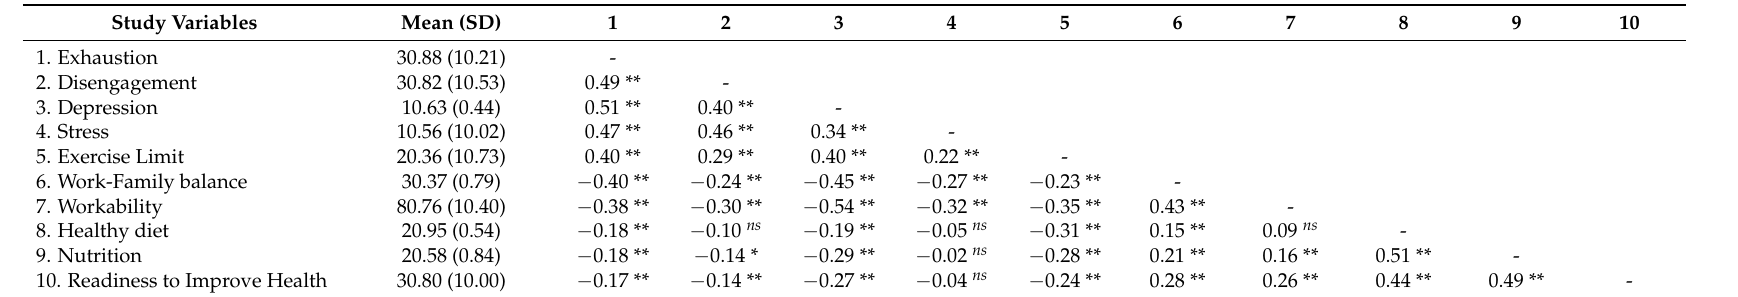
Table 1. Means, Standard deviations (SD), and correlations of the study